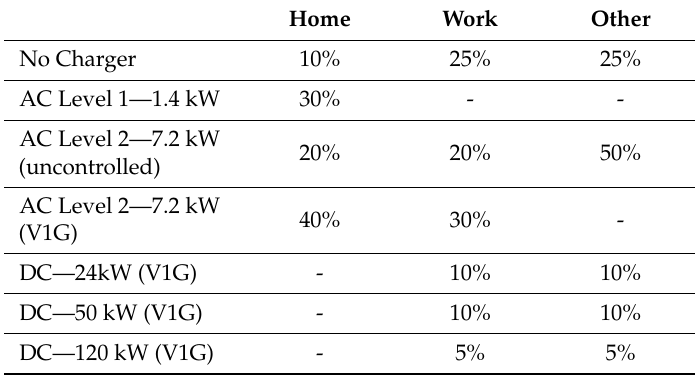
Table 14. Charging Infrastructure Assumptions 2030 (Managed V1G). Home Work